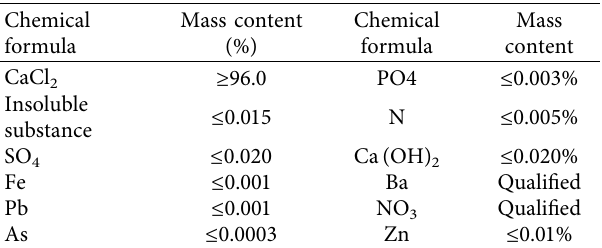
Table 2: Mass indicators for internal components of anhydrous CaCl 2